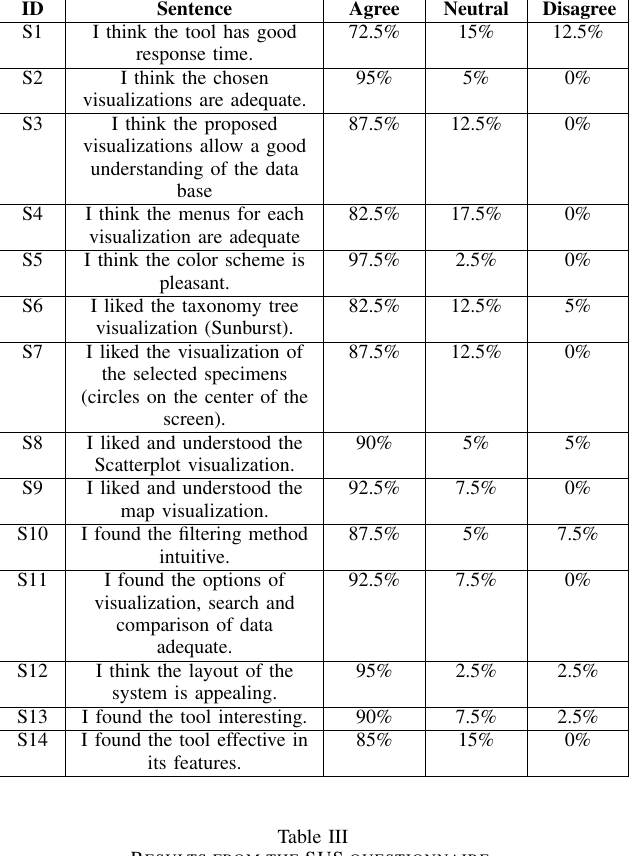
Table II R ESULTS FROM THE SURVEY MEASURING USER SATISFACTION IN RELATION TO INTERFACE DECISIONS .